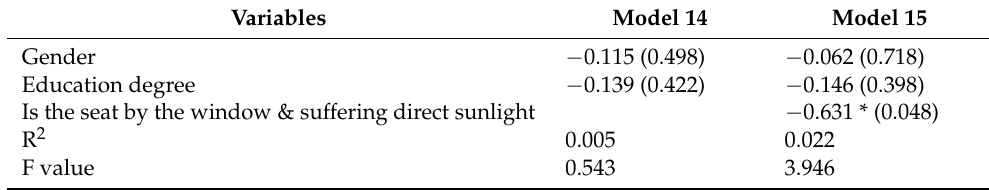
Table 6. Post hoc analysis on unit1 with “Learning efficiency” as the dependent variable (N = 280). Variables